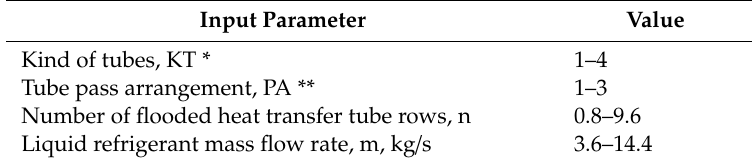
Table 6. The extended ranges of inputs used in the optimization study by AGENN